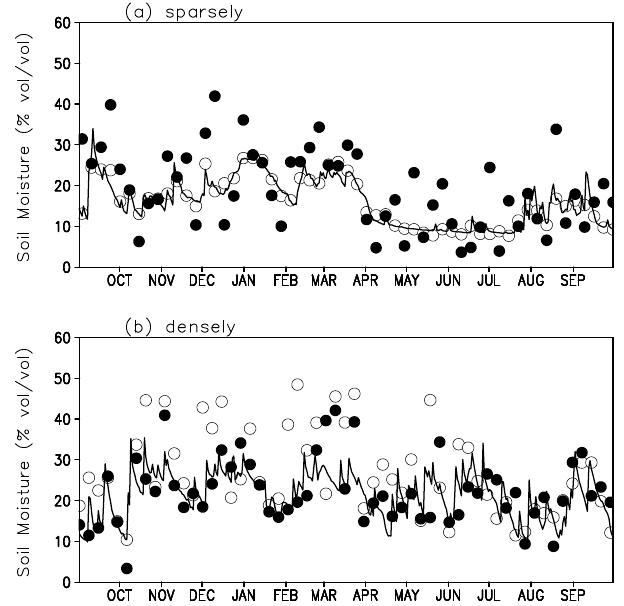
Fig. 3. Time variations of daily soil moisture (% vol/vol) retrievals from radiometer (open circle) and scatterometer (closed circle) at 29 ◦ incidence angle compared with the truth (black line) at (a) sparsely and (b) densely vegetated pixels from September 2002 to September 2003.